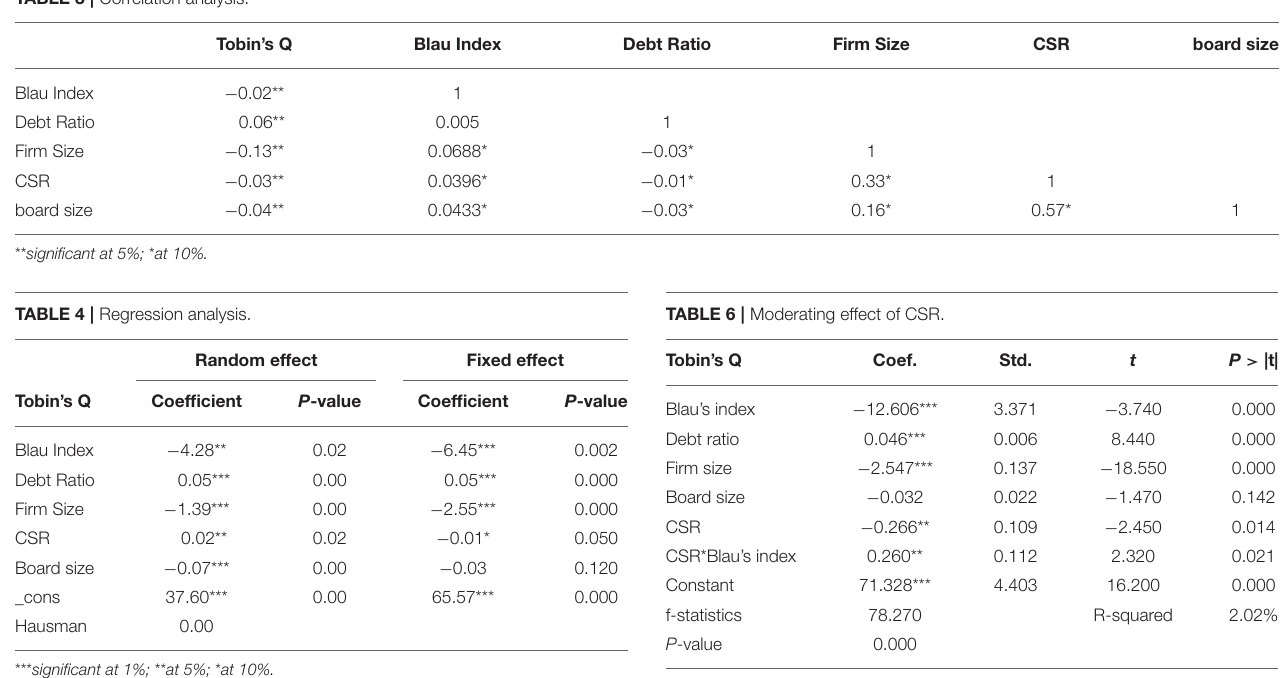
TABLE 3 | Correlation analysis.